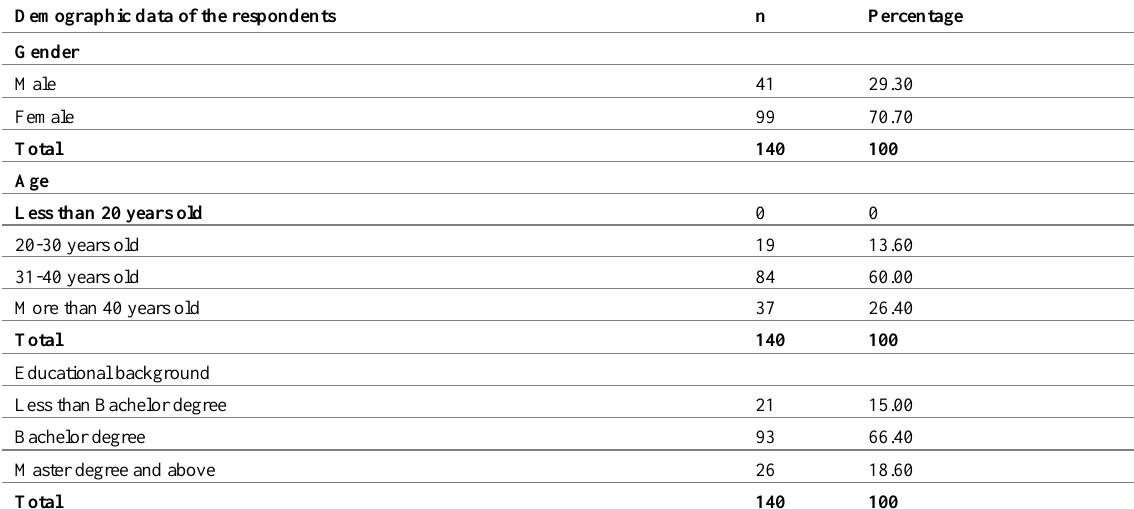
Table 1: Results of the Demographic Data of the Respondents